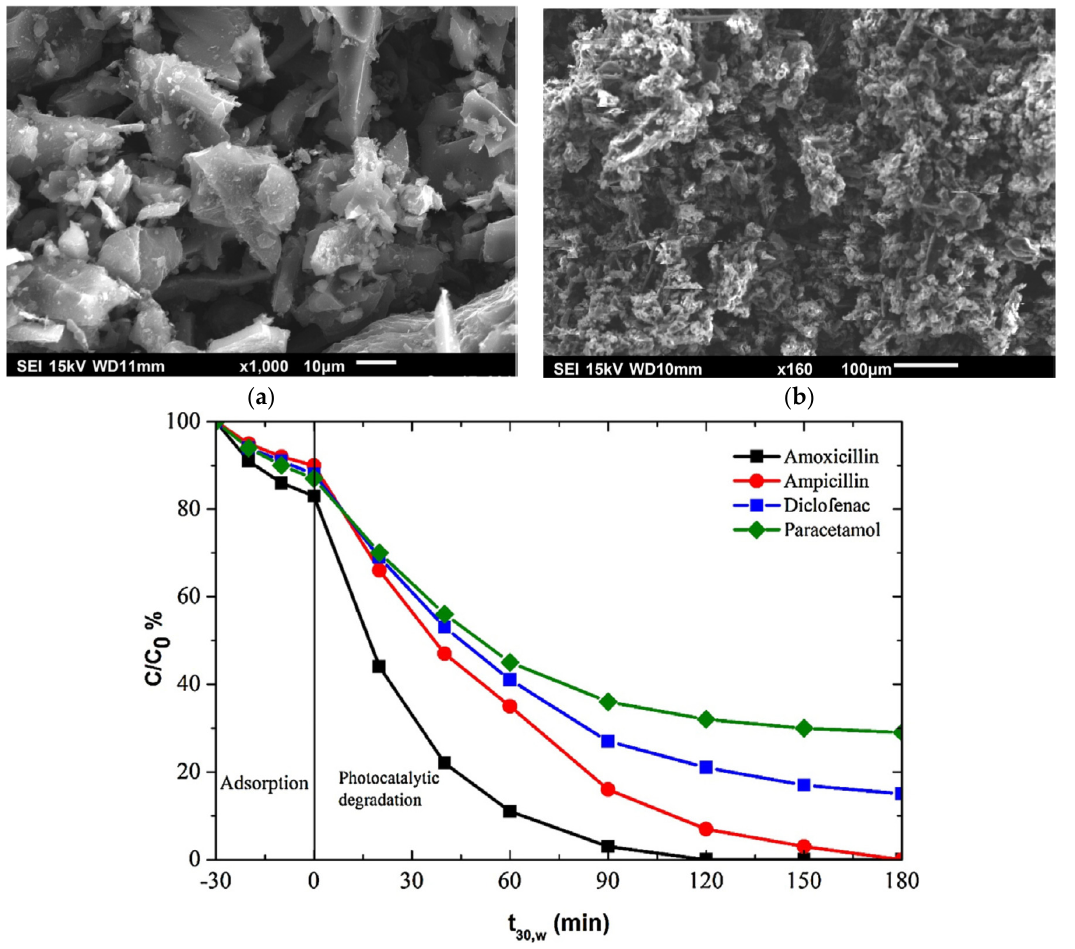
Figure 18. Morphology of TiO 2 and TiO 2 /AC, and the pharmaceutical degradation property of TiO 2 /AC: ( a ) SEM image of TiO 2 , ( b ) SEM image of TiO 2 /AC, and ( c ) time-dependent concentration of pharmaceutical products in the photocatalytic degradation process by the TiO 2 /AC catalyst. The initial concentration of all pharmaceuticals ( c o ) was 50 mg/L. The TiO 2 /AC dosage was 1.2 g/L. Reprinted with permission from [29], ©2016 Elsevier Ltd.